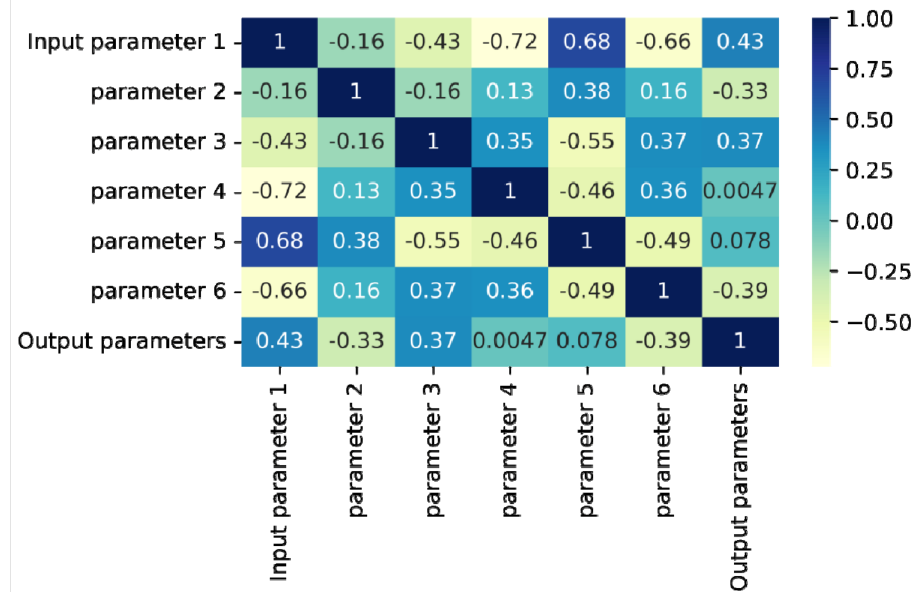
Figure 17. Heat map of the correlation coefficient.